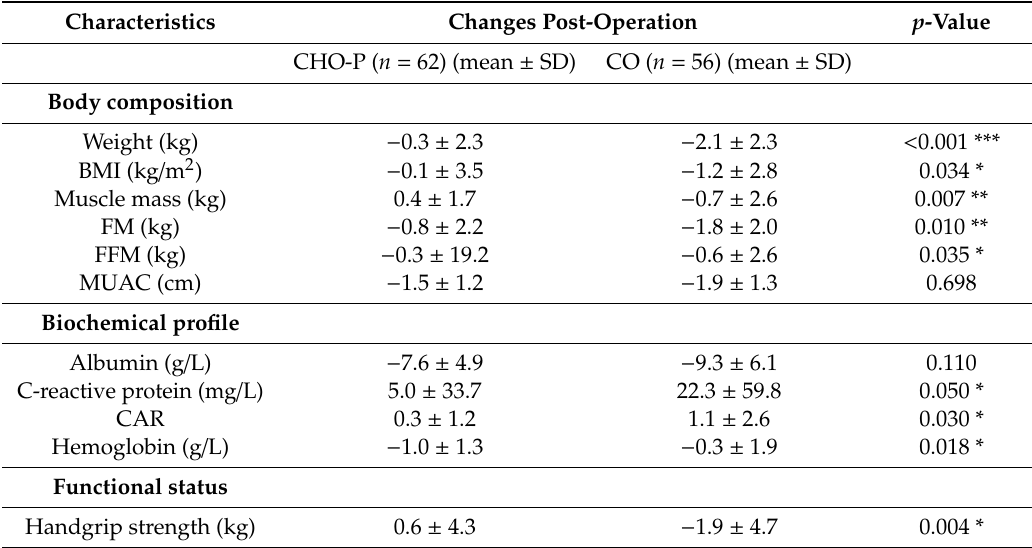
Table 7. Comparison of postoperative nutritional, biochemical, and functional outcomes of surgical GC patients between intervention (CHO-P) and control groups